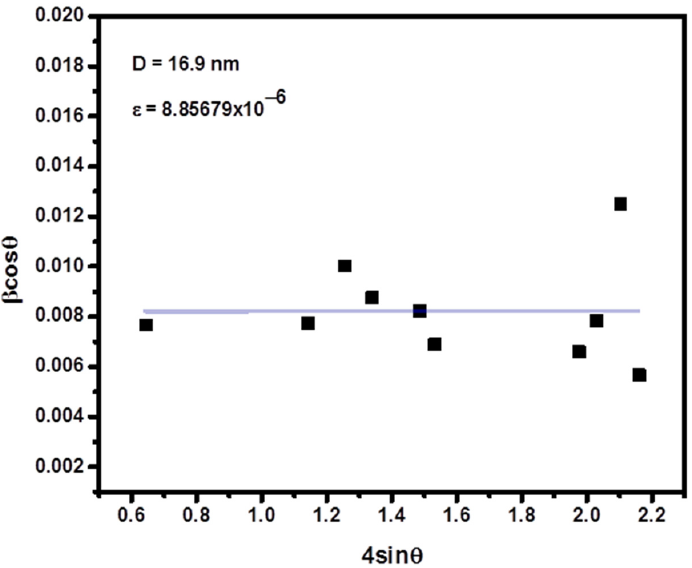
Figure 2. Williamson–Hall plot (W-H analysis) of Fe-Mg binary oxide nanoparticles.